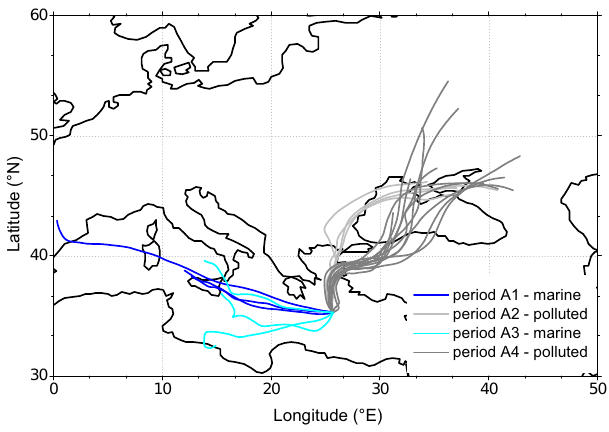
Fig. 5. Backward trajectories (duration 72h, start height 500m) during ARIADNE, as calculated using the NOAA HYSPLIT model.